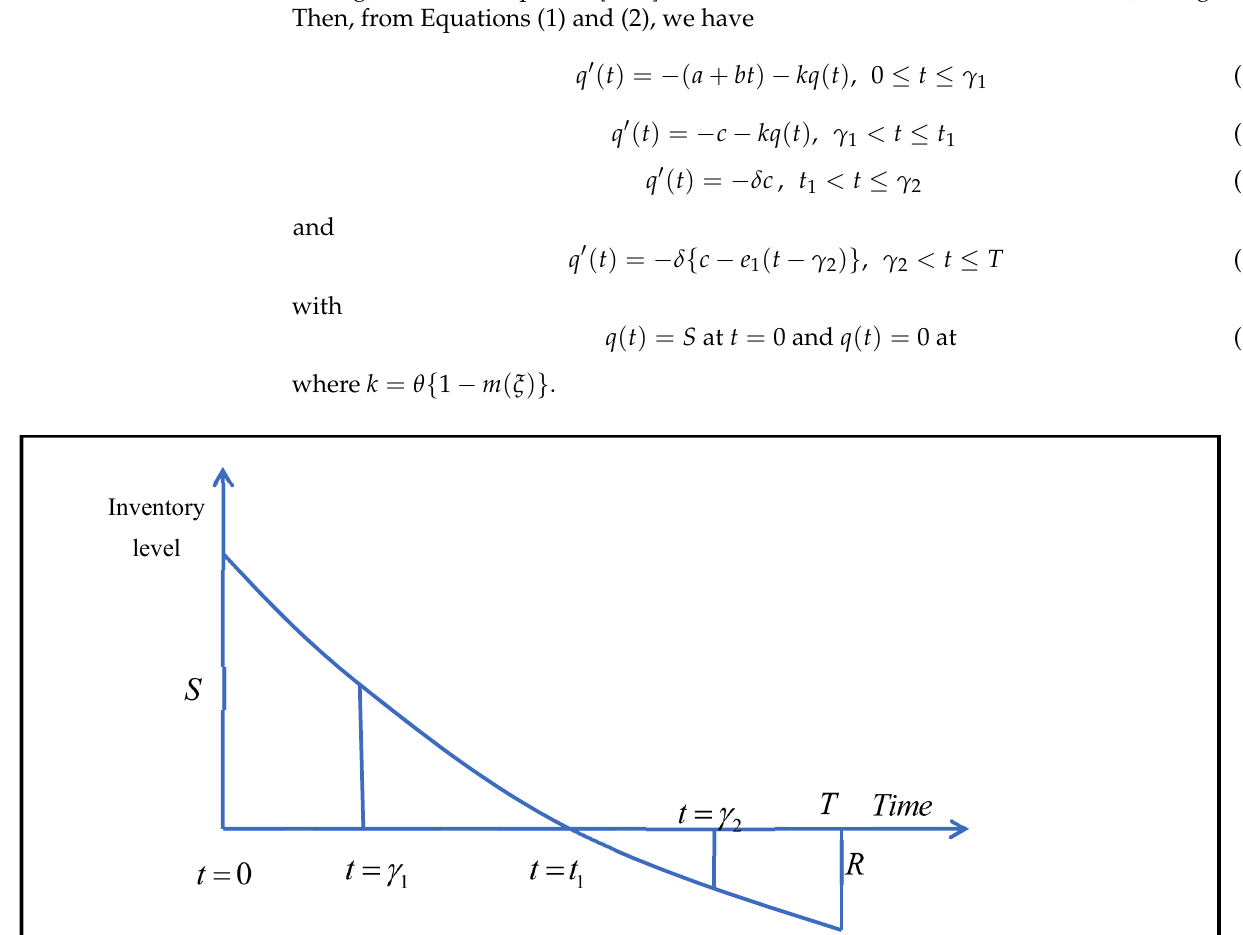
Figure 3. Pictorial representation of inventory situation under Case-II.